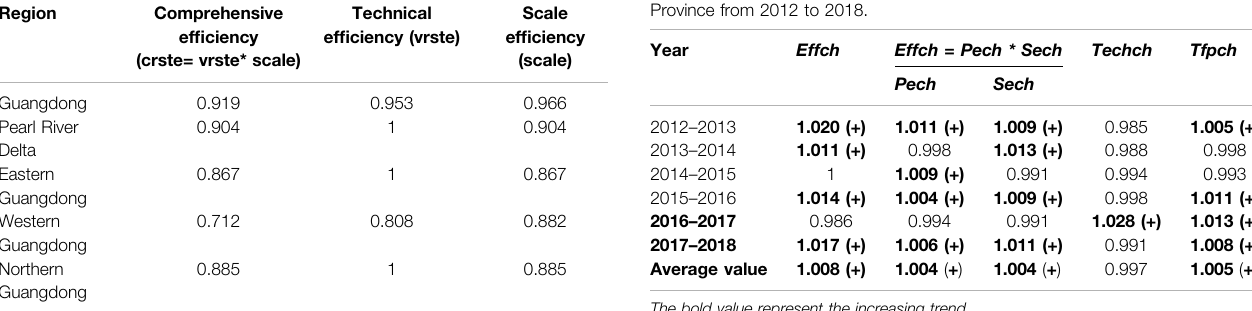
TABLE 4 | Malmquist Index and its Decomposition Results in Guangdong Province from 2012 to 2018.